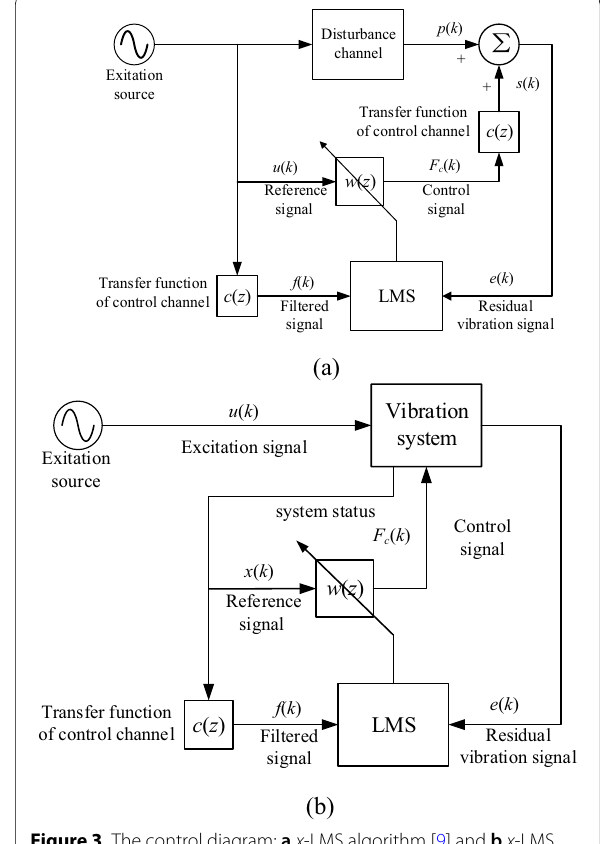
Figure 3 The control diagram: a x -LMS algorithm [9] and b x -LMS algorithm with state